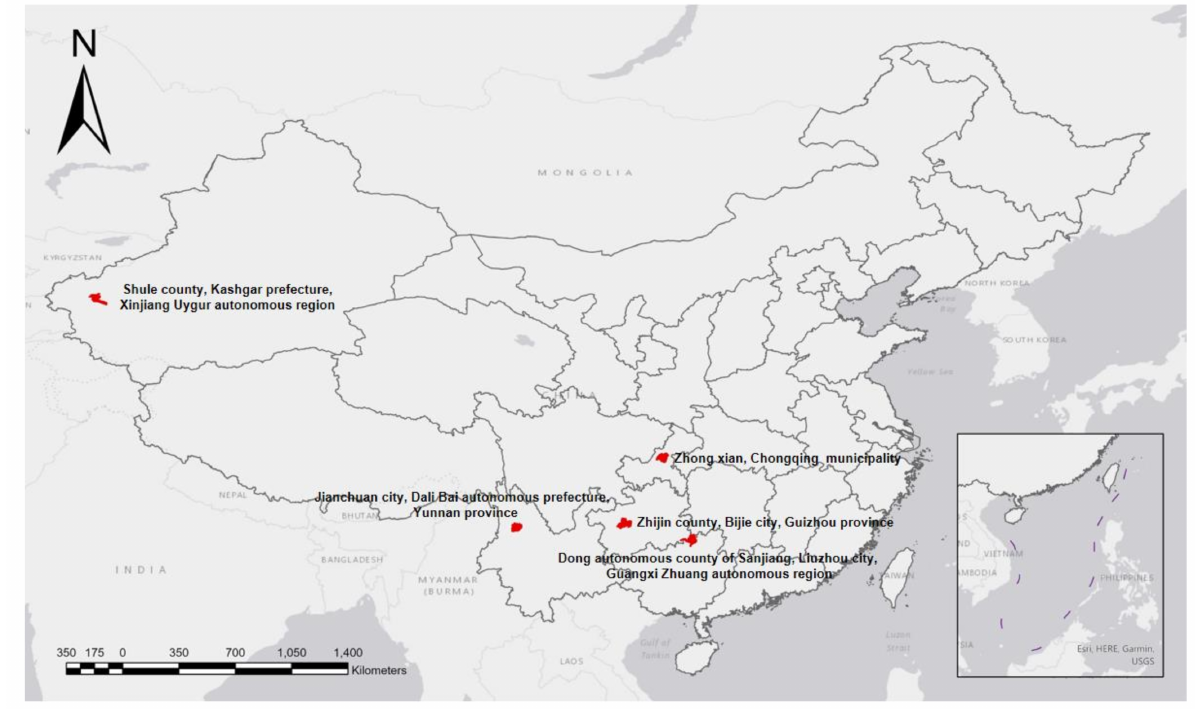
Figure 1. Locations of provinces where the study was